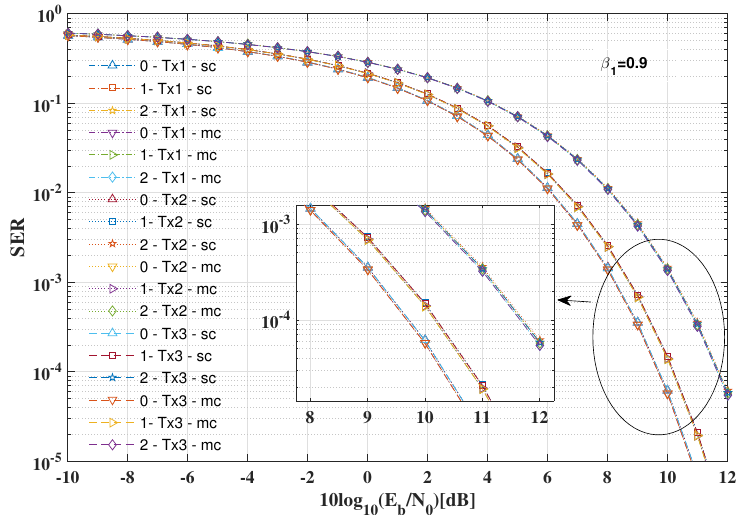
Figure 11. Robustness of the proposed DM schemes with various estimation errors of the desired